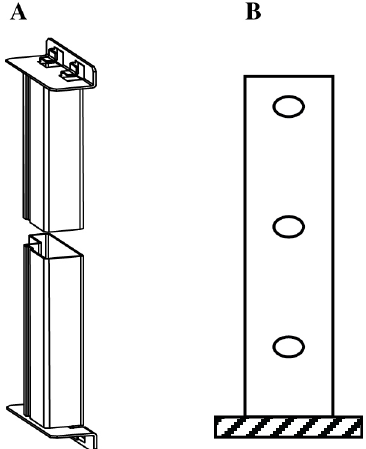
Figure 2: (A) Specimen without holes; (B) holed specimen.